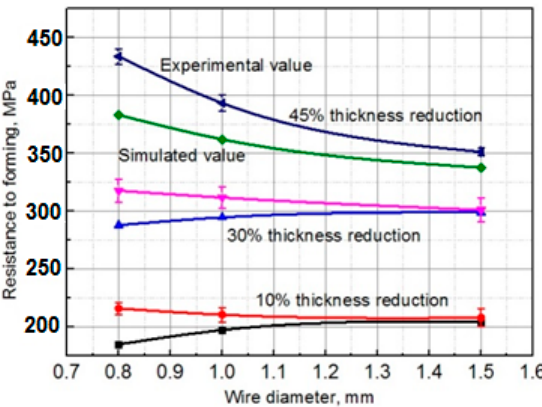
Figure 10. Forming resistance of pure copper wires under various reductions (10%, 30% and 45%) and wire diameters (0.8 mm, 1.0 mm and 1.5 mm).